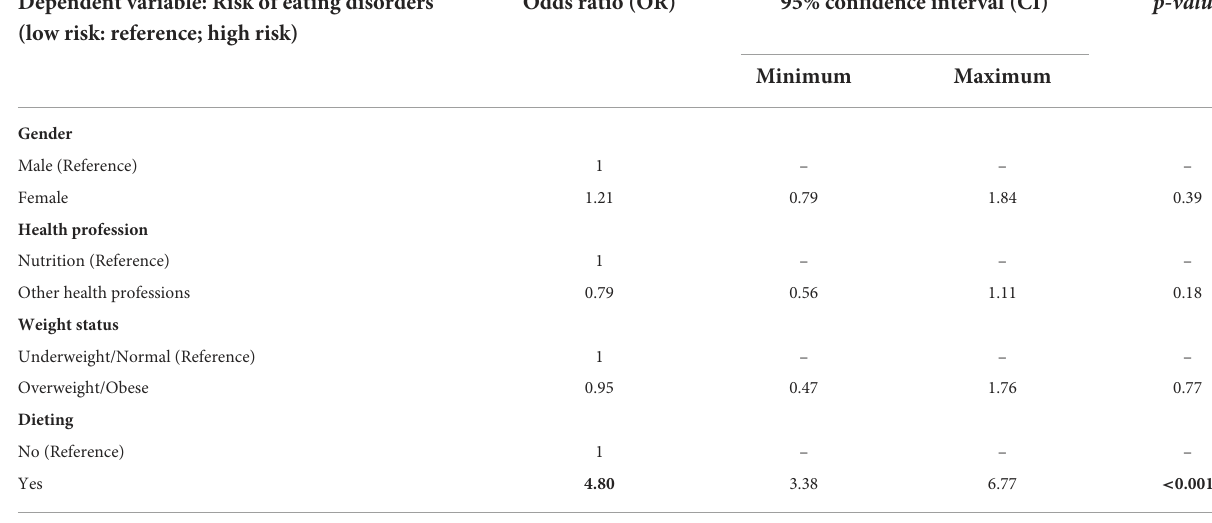
TABLE 3 The predictors of eating disorders.